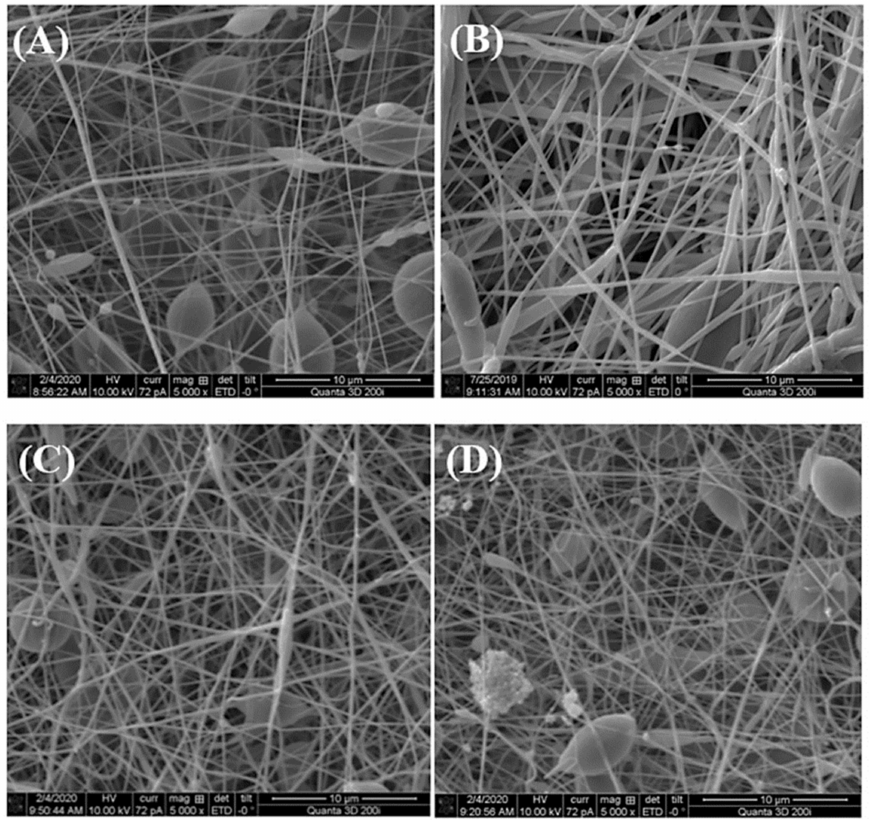
Figure 11. SEM images of electrospun ( A ) pure PCL, ( B ) PCL and 6 wt.% HNT nanofibers, ( C ) PCL and 6 wt.% HNT/ERY (80:20), and ( D ) PCL and 6 wt.% HNT/ERY 60:40. Reproduced from Ref.